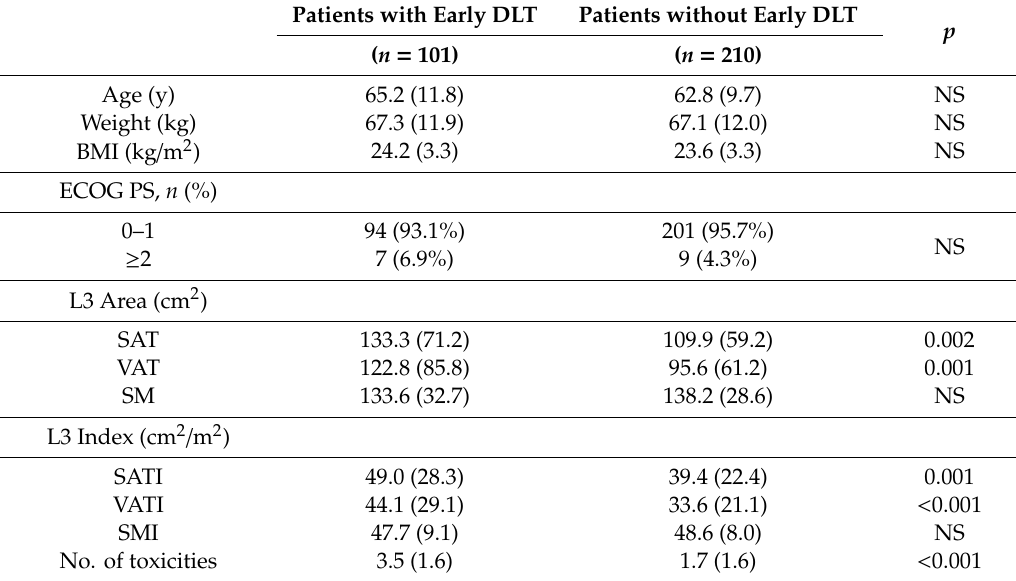
Table 2. Comparison of anthropometric measurements and demographic characteristics of patients with or without early DLT.